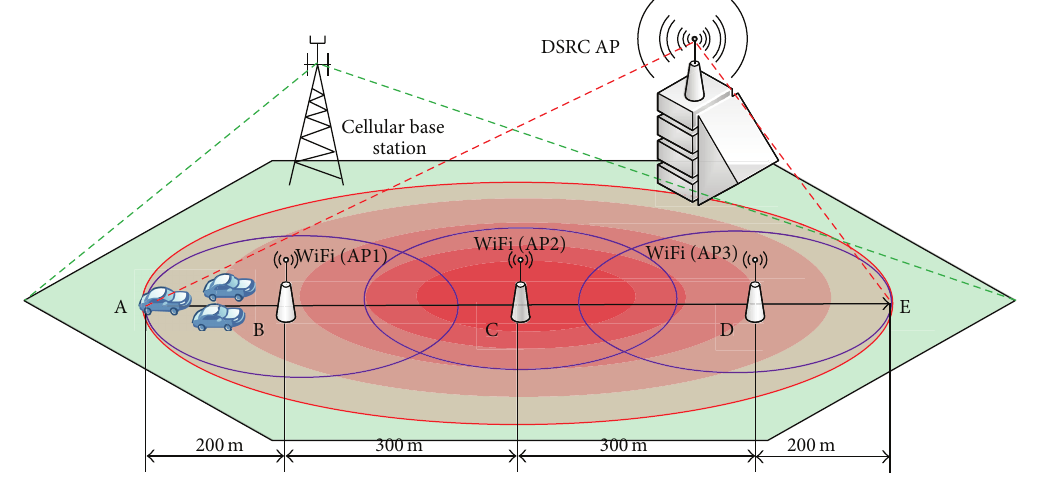
Figure 5: A simulation scenario.